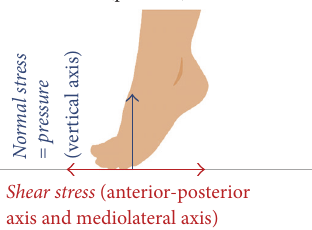
Figure 2: Normal stress (pressure) is vertical axis. Shear stress is the resultant force of anterior-posterior axis and mediolateral